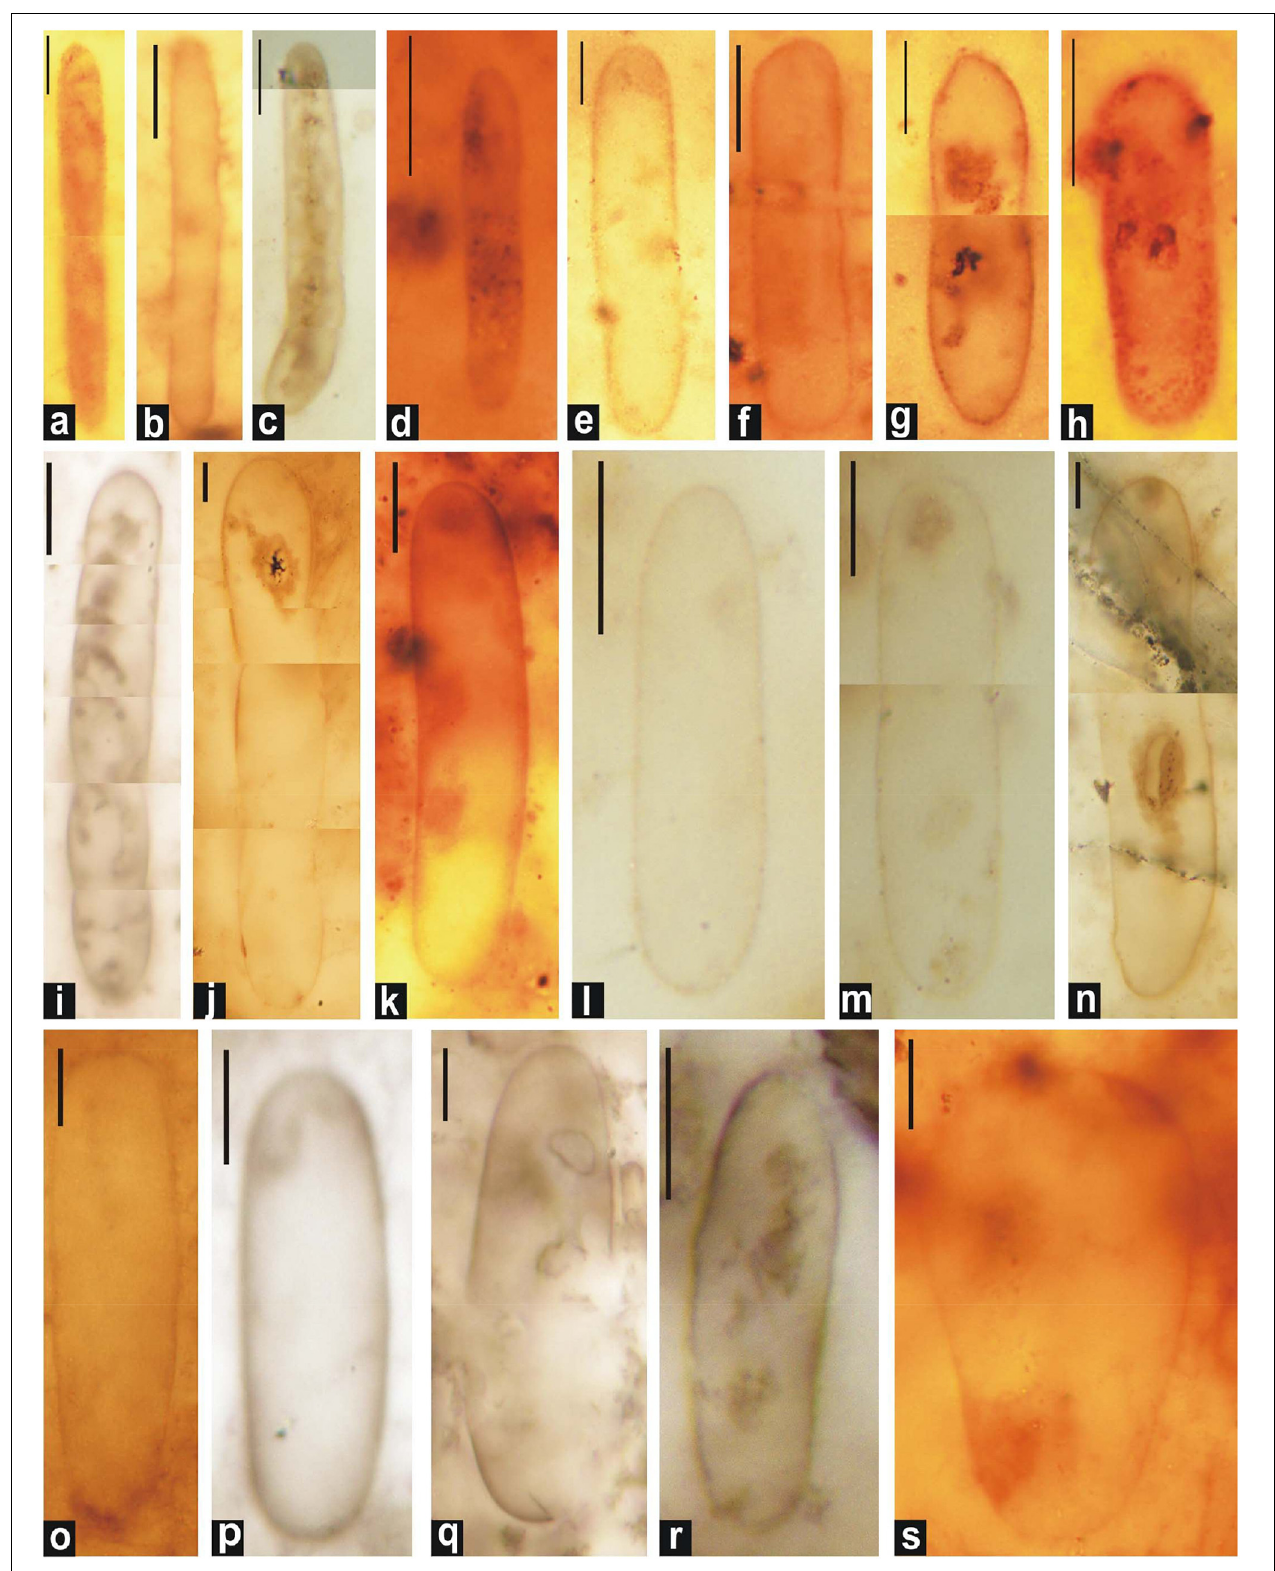
FIGURE 5 | Photomicrographs of single-walled akinetes in petrographic thin sections of chert. (c, e, and l) Archaeoellipsoides bactroformis ; (i,o) A . conjuctivus ; (b,d) A . dolichos ; (a,f) A . elongatus ; (j,k,n,q, and s) A . grandis ; (g,m,p, and r) A . major ; (h) A . minor . Scale bar = 10 µ m.